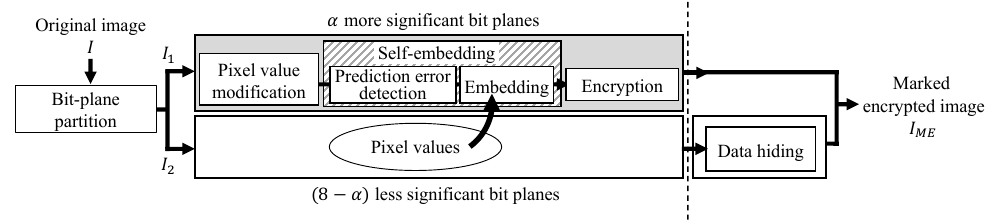
Figure 1. Block diagram of proposed method and RDH-BPP method